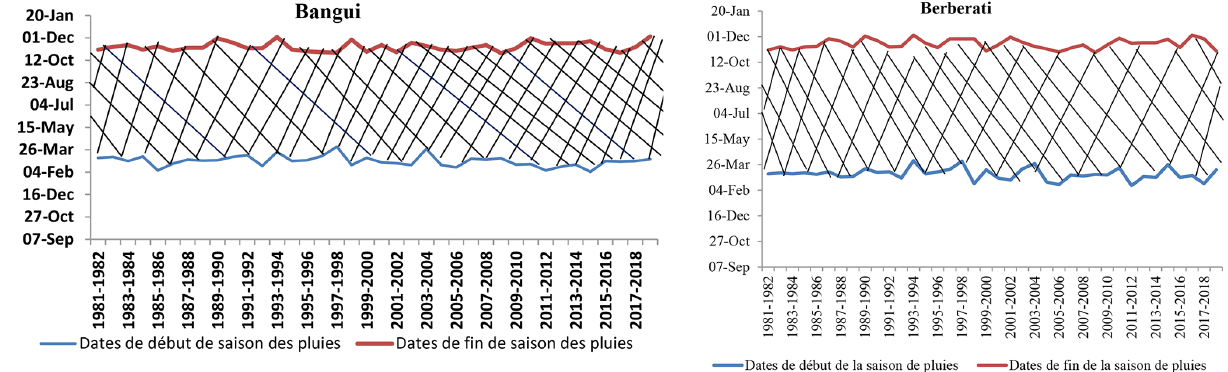
Figure 2. Variation interannuelle des dates de début et de fin de saisons des pluies à Bangui et Berberati de 1981 à